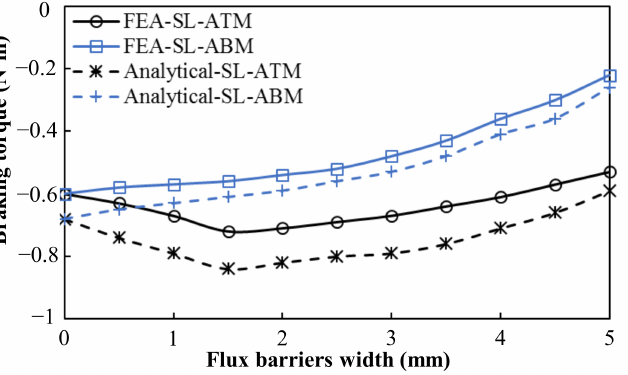
Figure 9. Variation of the braking torque with the width of flux barriers at 1000